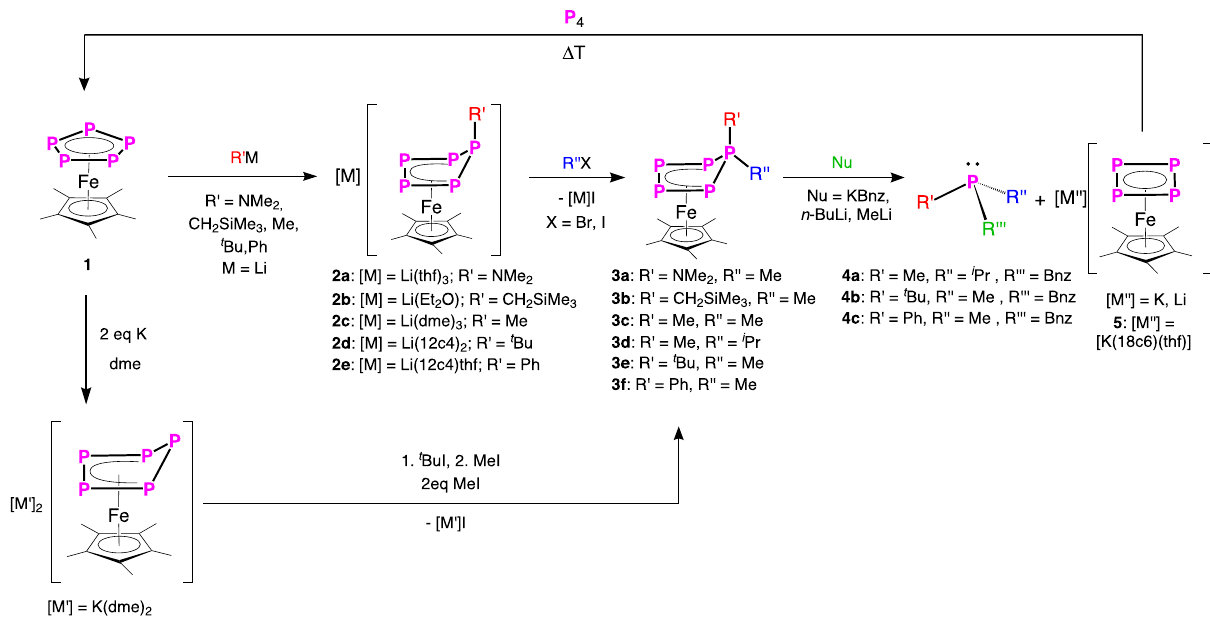
Fig. 2 Synthesis of asymmetric phosphines 4, via successive nucleophilic, electrophilic, nucleophilic attack. Synthesis of the anionic precursor complexes 2 by nucleophilic attack; electrophilic quenching of 2 (synthesis of 3 ); asymmetric phosphine abstraction by nucleophiles (synthesis of 4 , 5 ); regeneration of 1 by thermolysis with P 4 ; alternative synthesis of 3 by electrophilic quenching of 1 ′